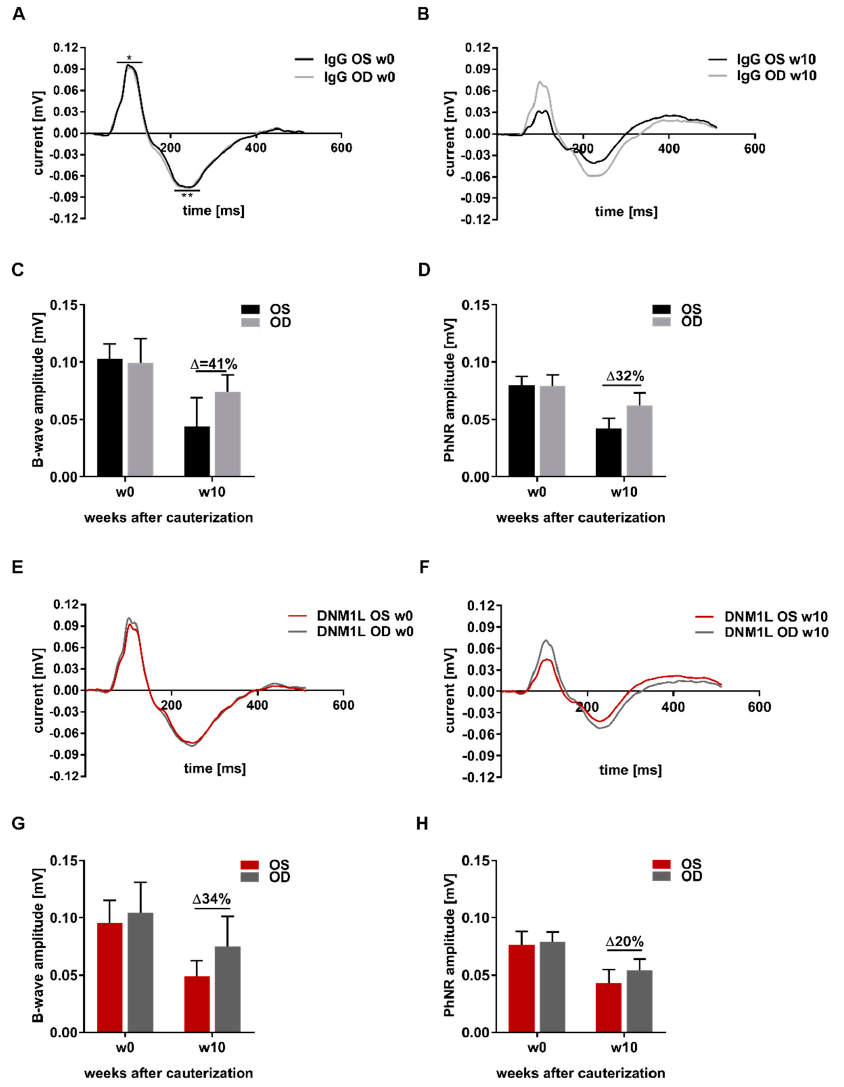
Figure 4. Analysis of retinal functionality using photopic Ganzfeld ERG. To determine retinal functionality, photopic Ganzfeld ERGs of a protocol with increasing light flash intensity were acquired. ERG recordings at baseline (w0, before episcleral vein occlusion, EVO) and at the final examination at w10 after EVO were arithmetically averaged. For the ERG recordings and quantification shown, the flash intensity 1.37 log10 cd·s·m − 2 was used. Thereby, the ERG profile for the IgG group in w0 ( A ) showed no difference between the left (OS) and right (OD) eyes. For quantification, the ampli- tudes of the profiles, B-wave (*), and photopic negative response (PhNR, **) were used. ( B ) The ERG profile of the IgG group at w10 showed a decrease in B-wave and PhNR amplitudes. ( C ) For quan- tification in the IgG group, B-wave amplitude ( C ) and PhNR amplitude ( D ) were analyzed. For the DNM1L group, ERG profiles were acquired at time point w0 ( E ) and time point w10 ( F ). B-wave amplitude ( G ) and PhNR amplitude ( H ) were analyzed for w0 and w10. The millivolt decrease was calculated as percent difference ( Δ = % change). Number of animals used: n = 7 (IgG), n = 8 (DNM1L).